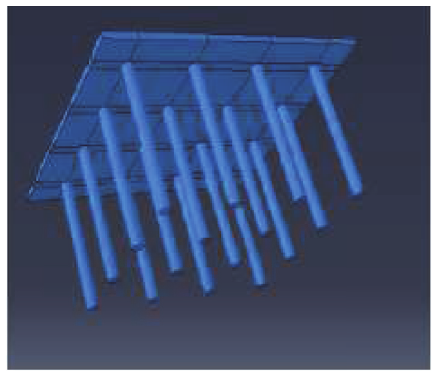
Figure 1: FEA of optimum piezoelectric